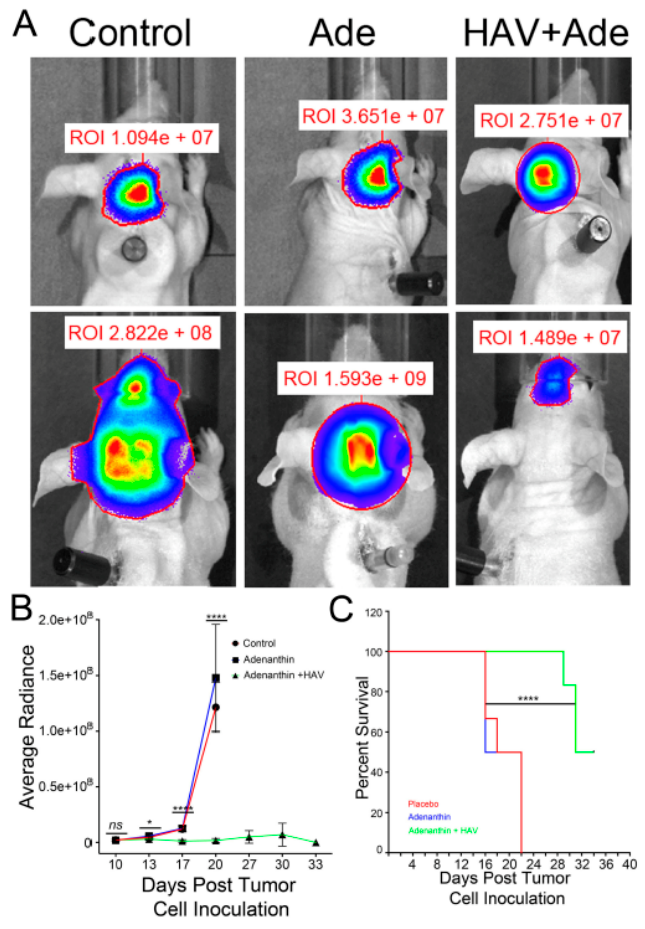
Figure 5. ( A ) Representative bioluminescence image of tumors in mice prior to the treatments (top panels) and following a 5-cycle treatment of control, Ade, or combination of HAV6 and Ade (bottom panel). ( B ) Quantitative analyses of the bioluminescence from tumors as outlined in the regions of interest (ROI) and normalized to background intensity for all tumor mice receiving control, Ade, or combination of HAV6 and Ade. ( C ) Kaplan-Maier survival curve of MBL tumor mice following the five-cycle treatment of control, Ade, or combination of HAV6 and Ade. Each treatment group consisted of six